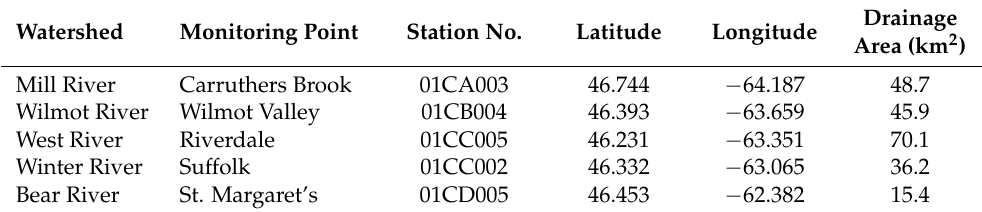
Table 1. The modeled watersheds and their streamflow monitoring points in PEI.